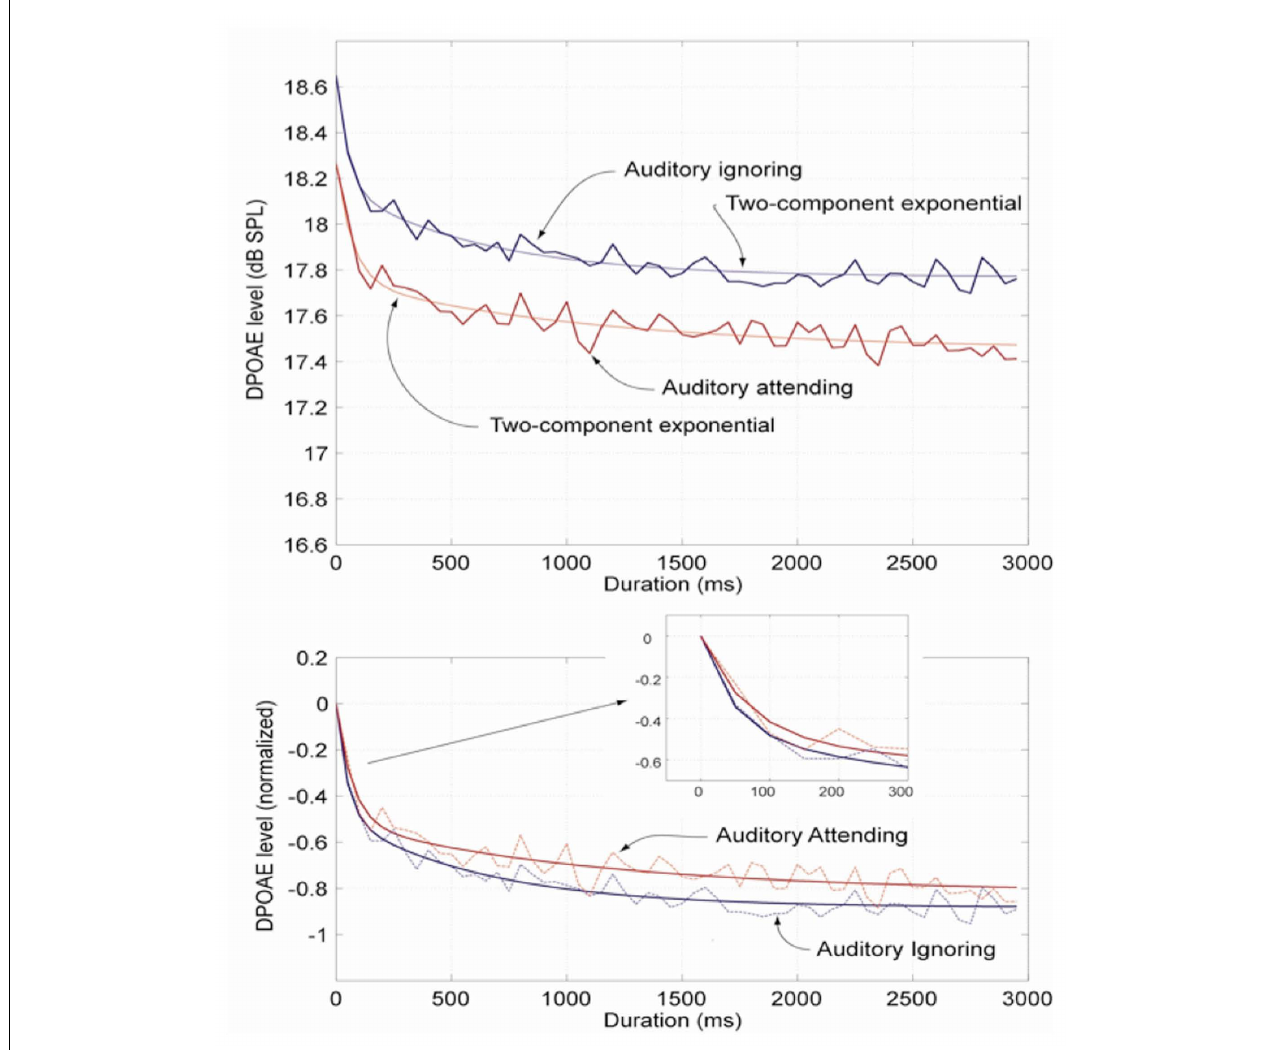
level (bottom panel, and inset), it can be seen that the onset slope is relatively steeper and there is relatively more rapid adaptation for the auditory-ignoring condition (blue) compared with the auditory-attending (red) condition.The estimated time constants are 49ms for the auditory-ignoring condition and 66ms for the auditory-attending condition, differences that are statistically indistinguishable (paired t -test).The estimated difference in overall DPOAE level is ∼